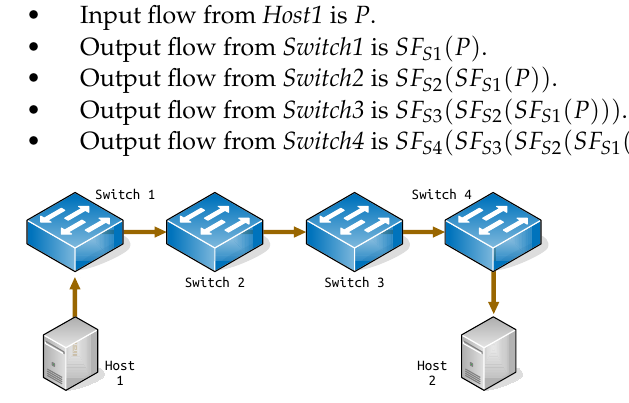
Figure 2. An example network ( C NET ) with chain topology.